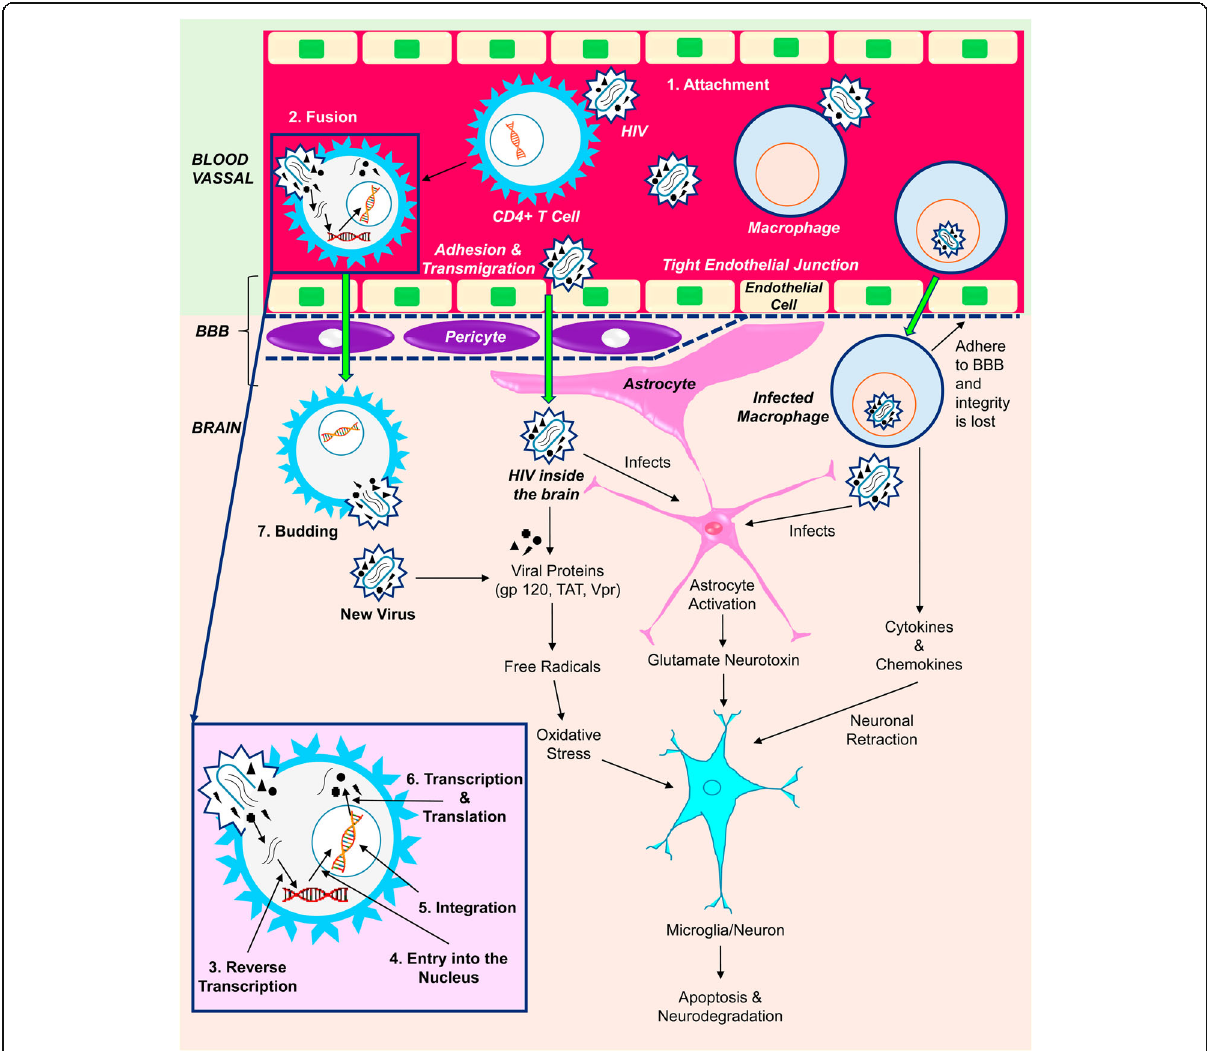
Fig. 1 Mechanism of viral infection and neurodegradation in neuroAIDS. The HIV can enter into the brain of the infected people across the BBB, BCSFB at the early stage via CD4, CXCR4, CCR5 receptors bearing cells such as lymphocytes, monocytes, and macrophages. The adhesion of these HIV infected cells to the endothelial layer of BBB, loosen its integrity, and thus facilitate the infected lymphocytes, monocytes, macrophages including free HIV to enter inside the CNS. They replicate in microglia and macrophages of brain, and thus create a HIV reservoir and provoke neuroAIDS. The neurodegradation in neuroAIDS is associated with the production and harmful effects of cytokines (TNF- α , IL-1 β ), chemokines and viral proteins (gp120, TAT and Vpr) on brain astrocytes and glial cells leading to necrosis/